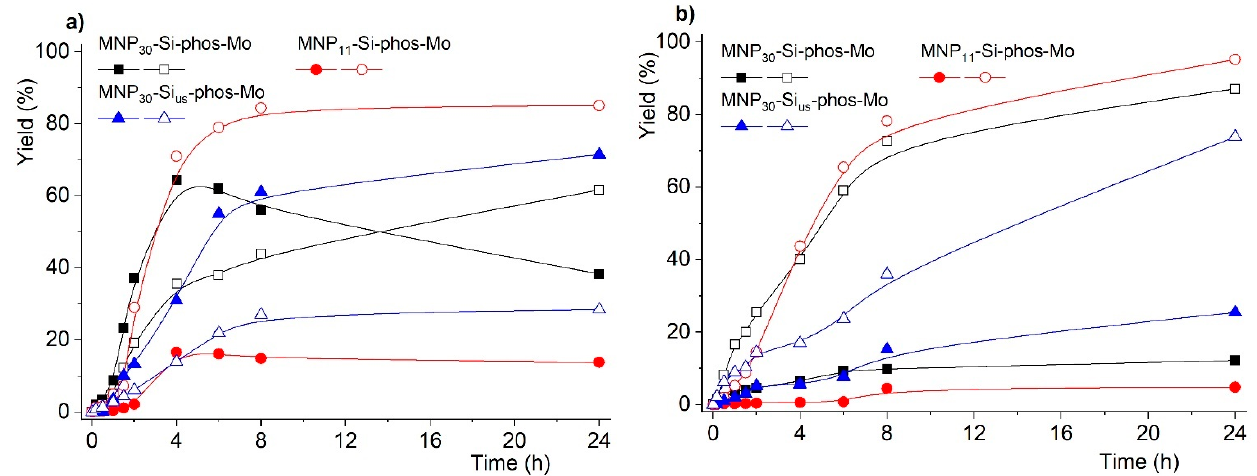
Figure 4. Styrene oxide (closed symbols) and benzaldehyde yield (open symbols) with acetonitrile ( a ) and toluene ( b ) as solvents at 353 K.